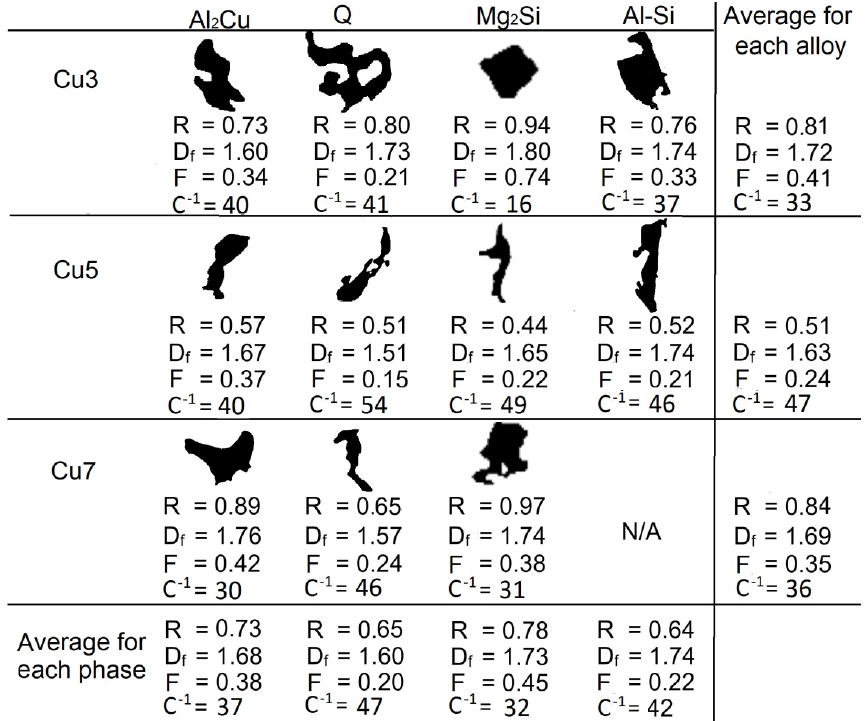
, F and C -1 for each individual phase for the experimental alloys. Figure 8. Behavior of R , D f